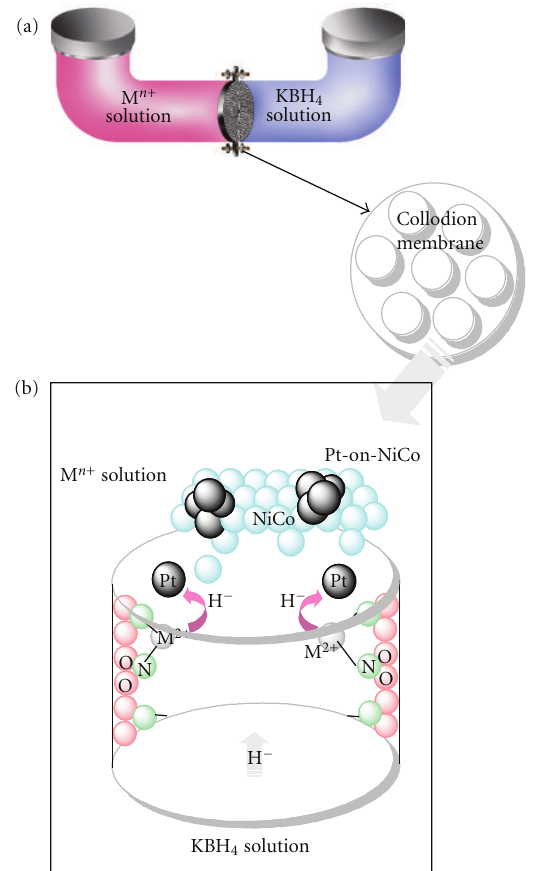
Scheme 1: (a) Experimental setup for synthesis of Pt-on-NiCo nanostructures. (b) Proposed process for formation of Pt-on-NiCo nano-